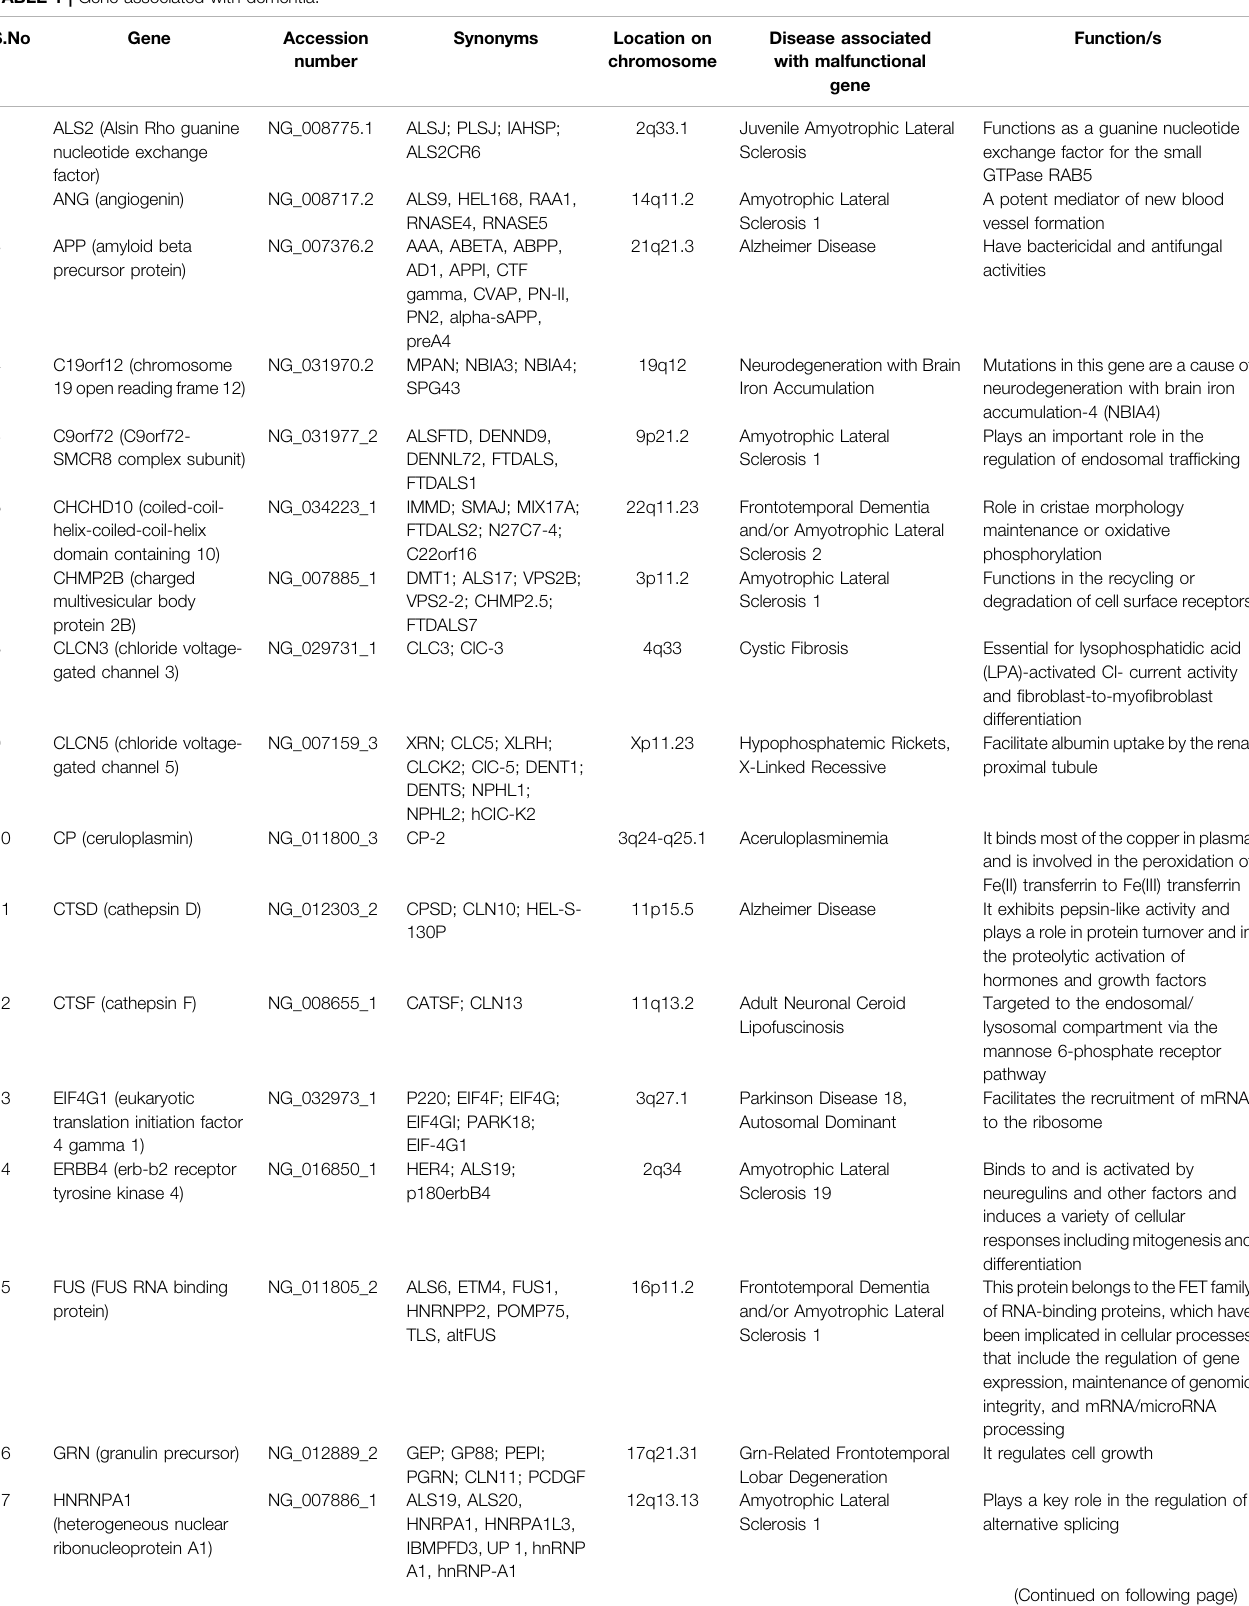
TABLE 1 | Gene associated with